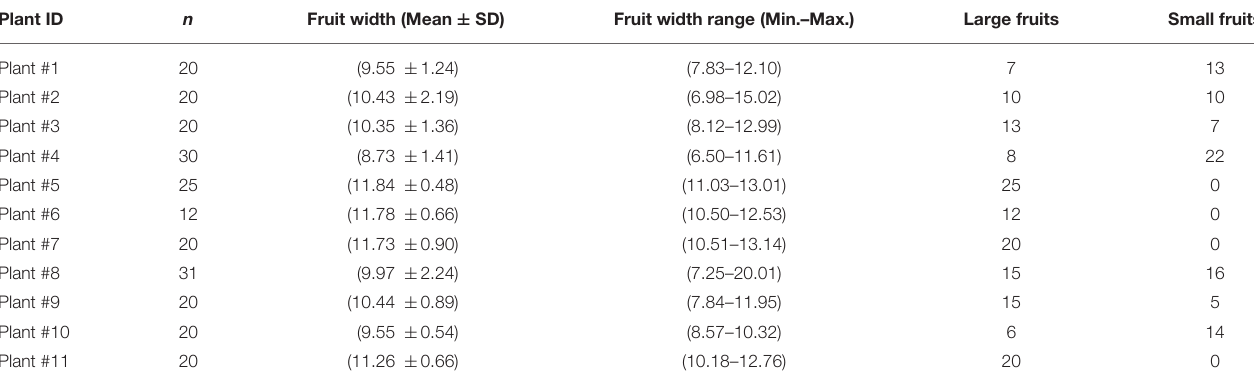
TABLE 1 | Summary of fruit width (mm) collected from individual trees. Plant ID n Fruit width (Mean ± SD) Fruit width range